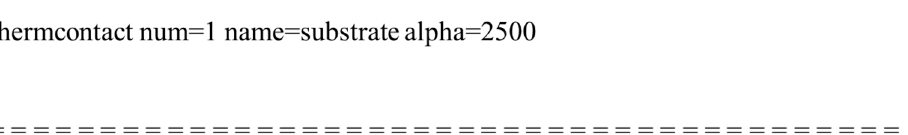
Figure 2. Physical models and parameters used in simulation code.